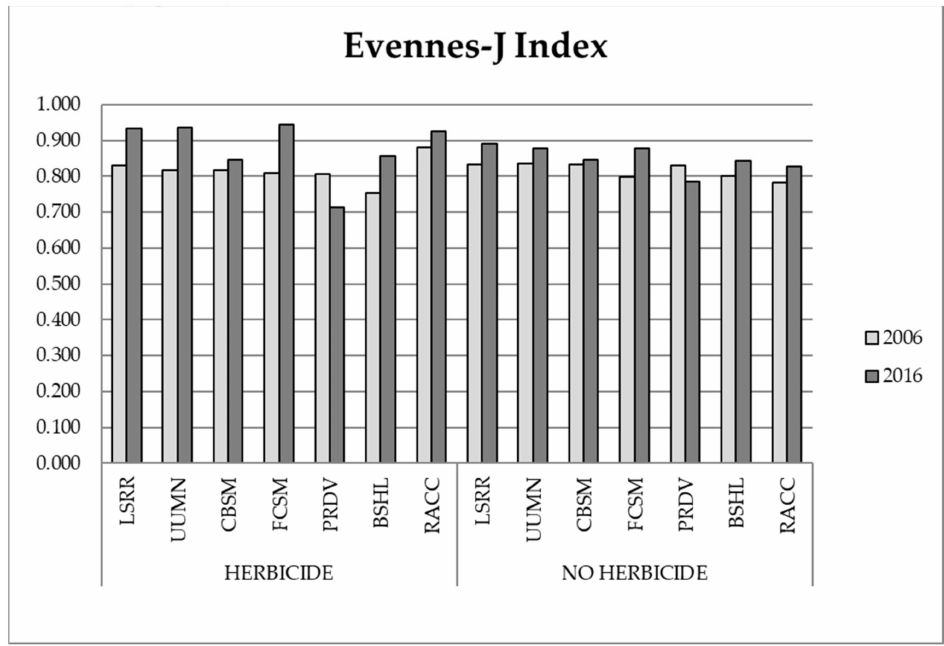
Figure 5. Assessment by the evenness index for the plant communities in the herbaceous covers under treatment with and without herbicides in the two time intervals